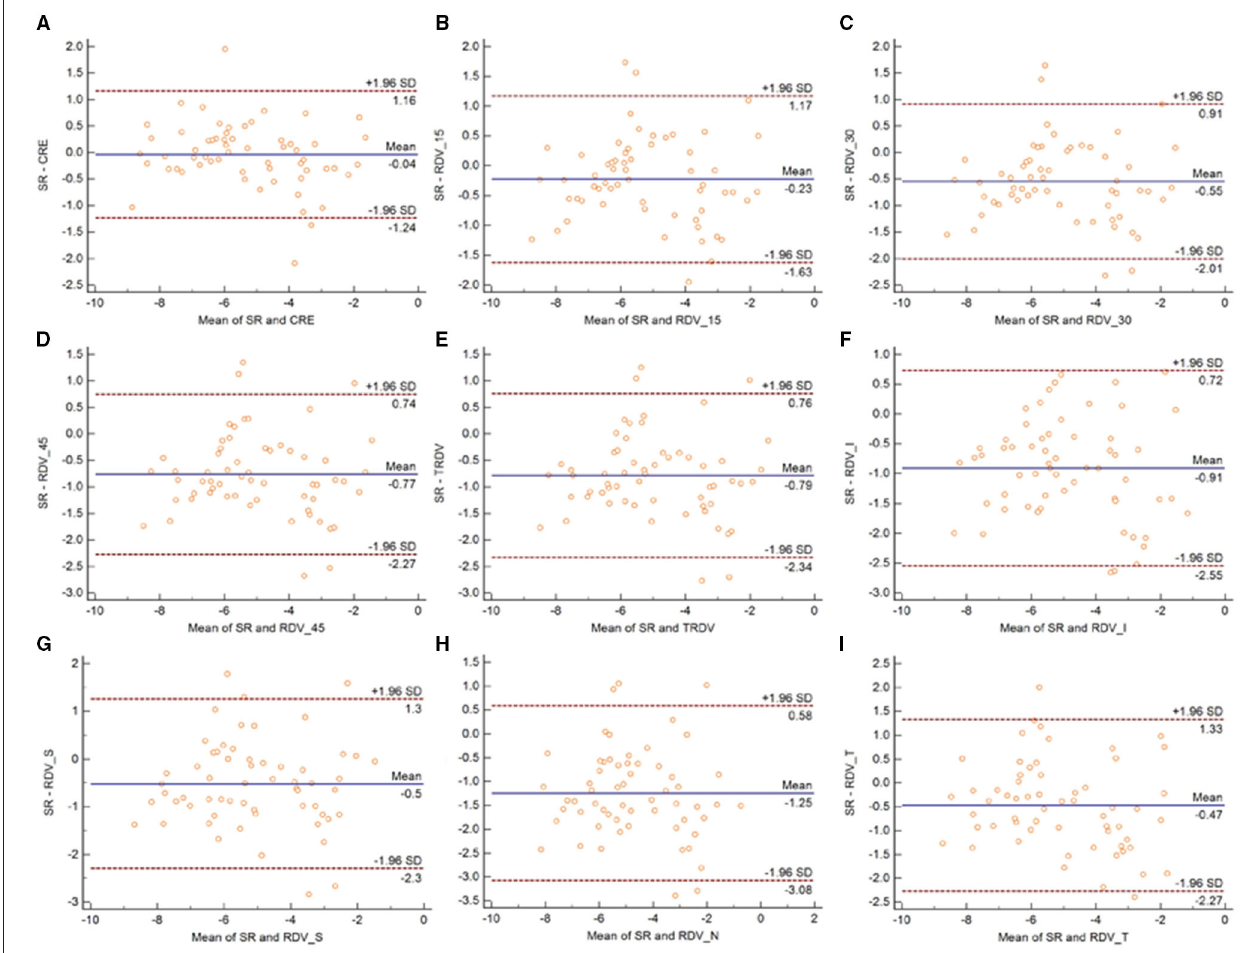
FIGURE 4 | Bland–Altman plots between OR and CRE (A) , RDV-15 (B) , RDV-30 (C) , RDV-45 (D) , TRVD I (E) , RDV-I (F) , RDV-S (G) , RDV-N (H) , and RDV-T (I) in non-cycloplegia eyes. The solid line shows the mean difference (bias), and the upper and lower lines represent 95% limits of